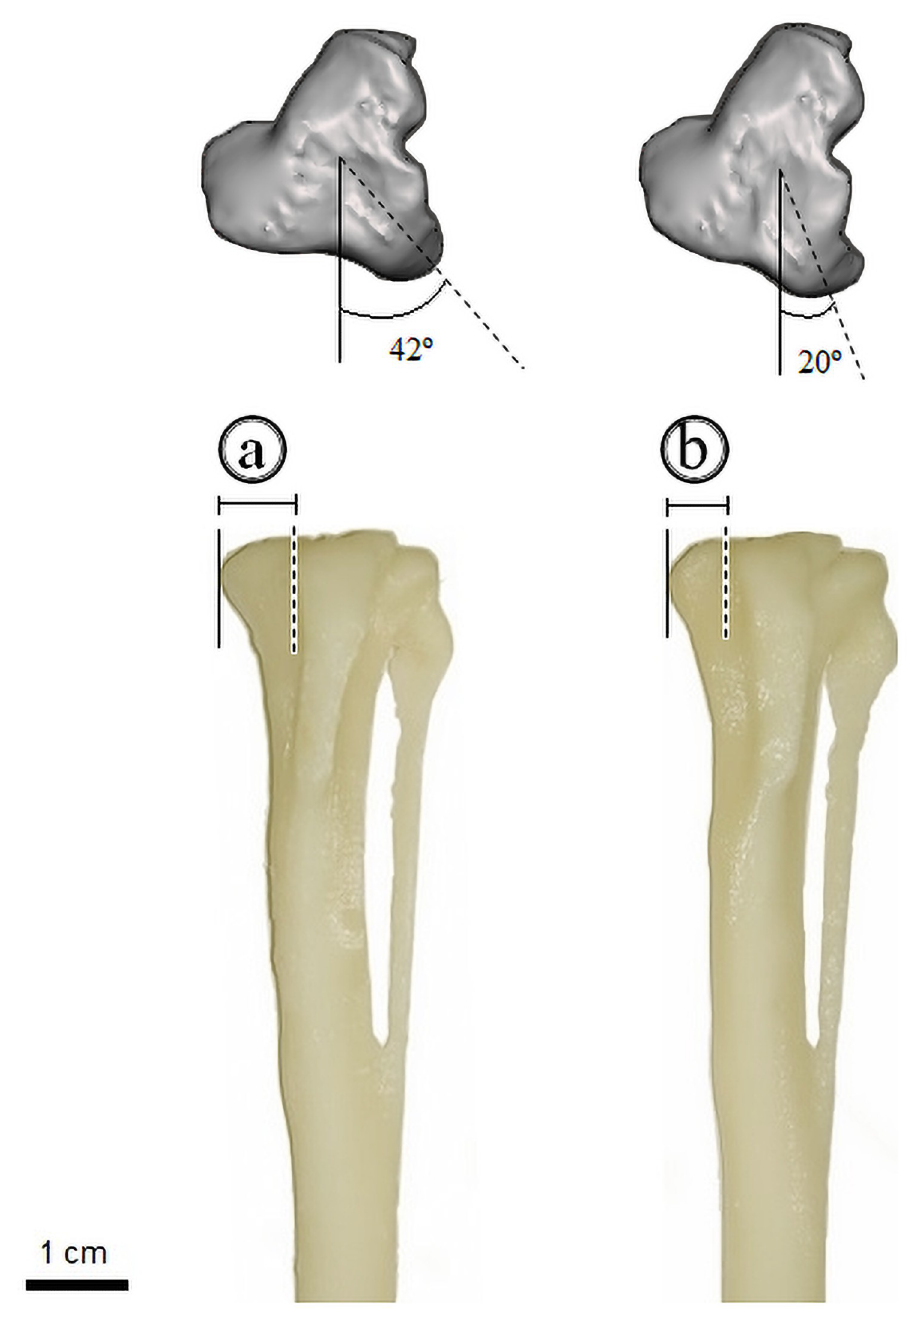
Fig 2. Difference between angulation and milimetry after the medial deviation of the tibial tuberosity. On the left is the healthy bone, in which the angulation of the tibial crest is 42˚ and the distance between its tuberosity and medial condyle is (a) = 0.75 cm. In the right is the bone with medial deviation, where the angulation is 20˚ and the distance turned (b) = 0.60 cm. The solid line is fixed, and the dotted line is